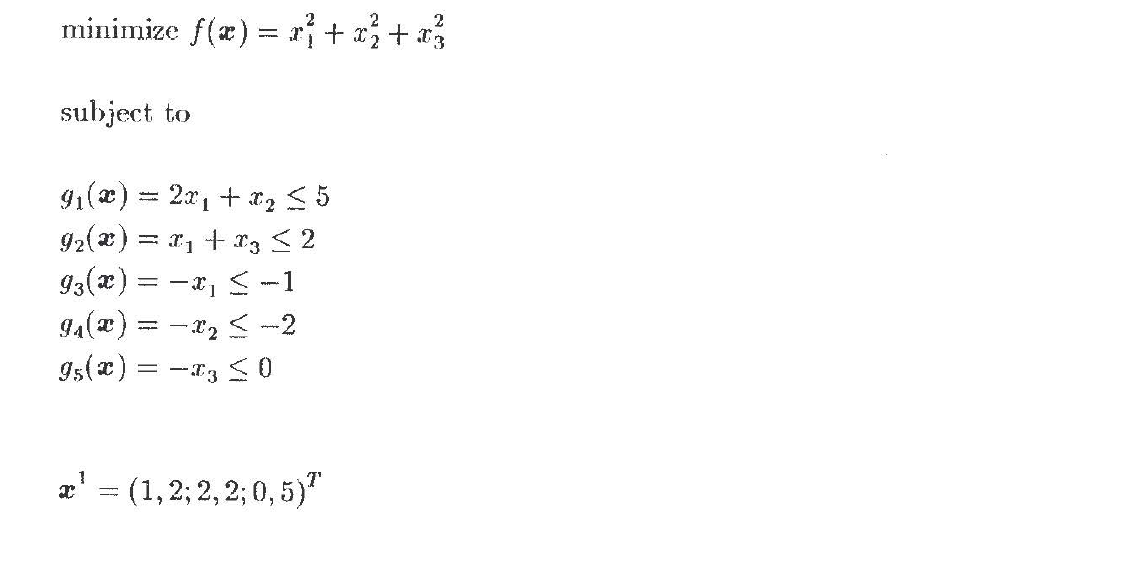
Example 2 A quadratic programming (QP) problem with solution at a vertex . .